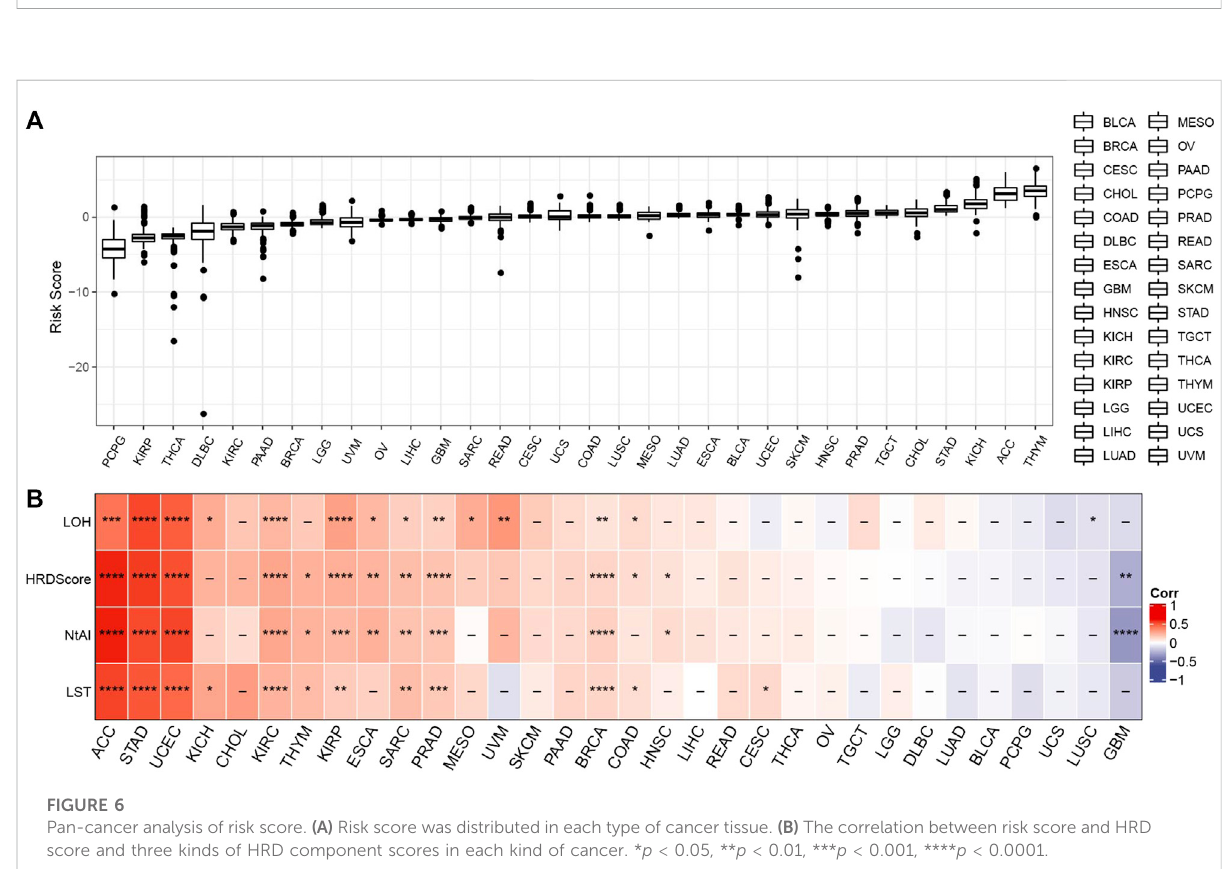
FIGURE 5 The performance of prognostic signature was evaluated in the validation set. (A) The survival curve of high-risk and low-risk groups in GSE66229 dataset. (B) Correlation between riskscore and Cisplatin and Talazoparib in GSE66229 dataset. (C) Sensitivity of Cisplatin and Talazoparib in two risk groups of GSE66229 dataset. (D) Survival results of high-risk and low-risk groups in GSE84437 dataset. (E) Pearson correlation between risk score and Cisplatin and Talazoparib in GSE84437 datasets. (F) Response analysis of high-risk and low-risk groups to Cisplatin and Talazoparib in GSE84437 dataset.